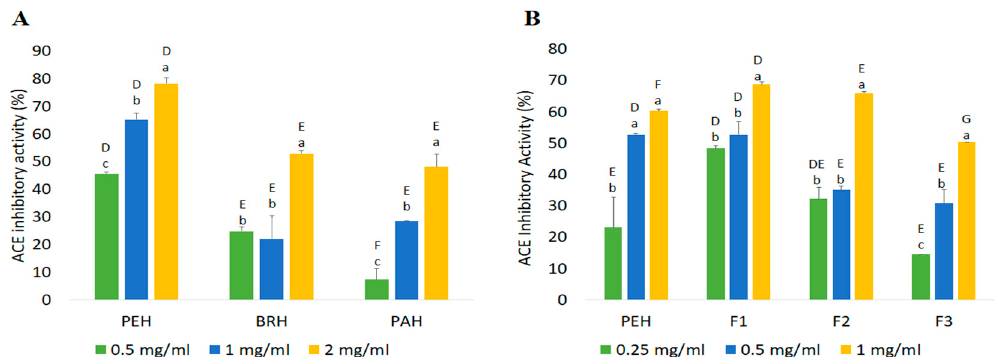
Figure 5. In vitro angiotensin I-converting enzyme (ACE) inhibitory activity of C angulata protein hydrolysates ( A ) and PEH fractions ( B ). Capital letters represent the significant difference ( p < 0.05) among samples at specific concentrations; and small letters among concentrations within each sample. Each value (in percentage) represents the mean ± standard deviation ( n = 3).